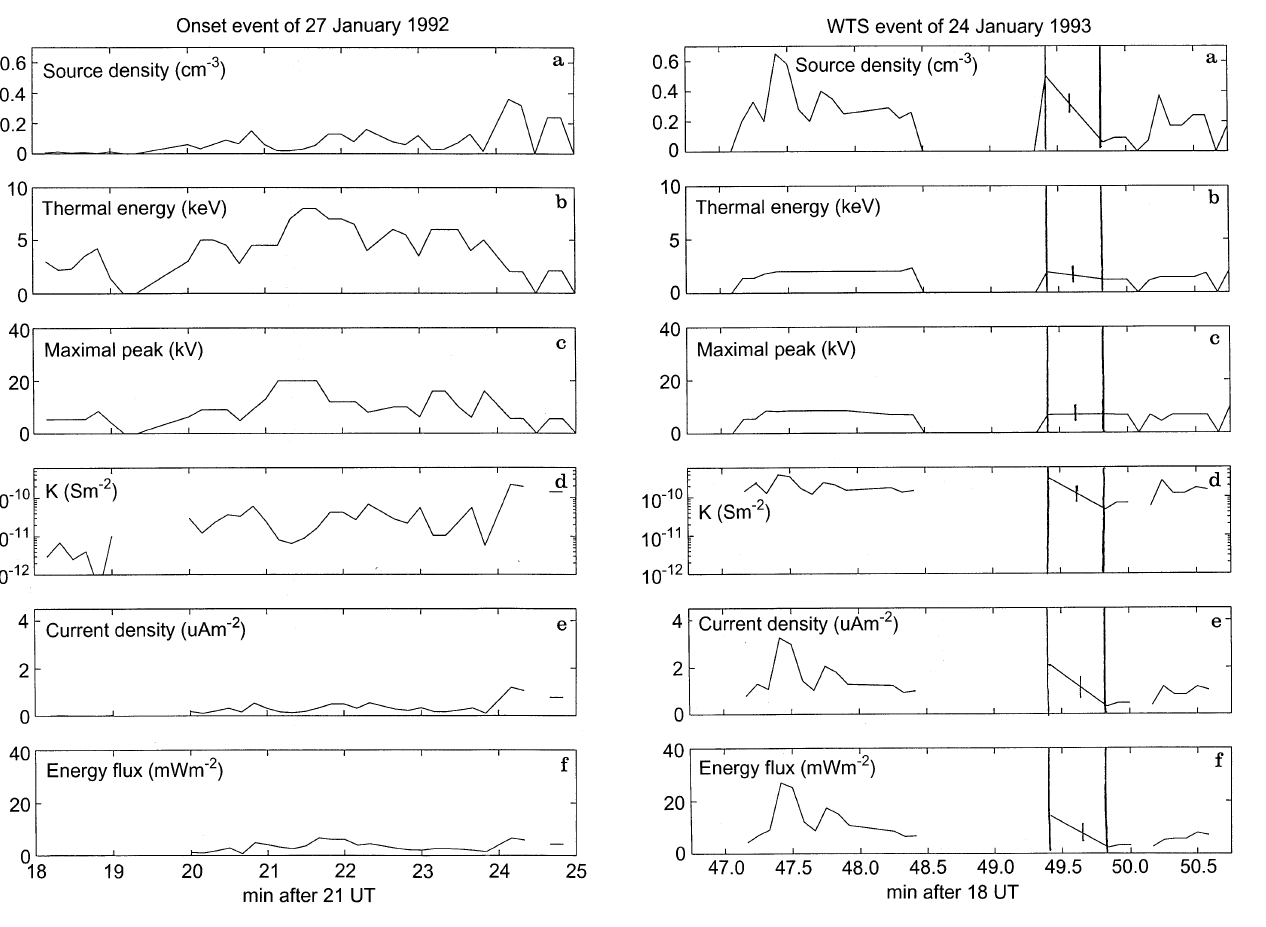
Fig. 4. a Source density, b thermal energy, c field-aligned conduc- tance, d potential drop, e current density and f energy flux esti- mated from each 5-s spectra during the 27 January 1992 event